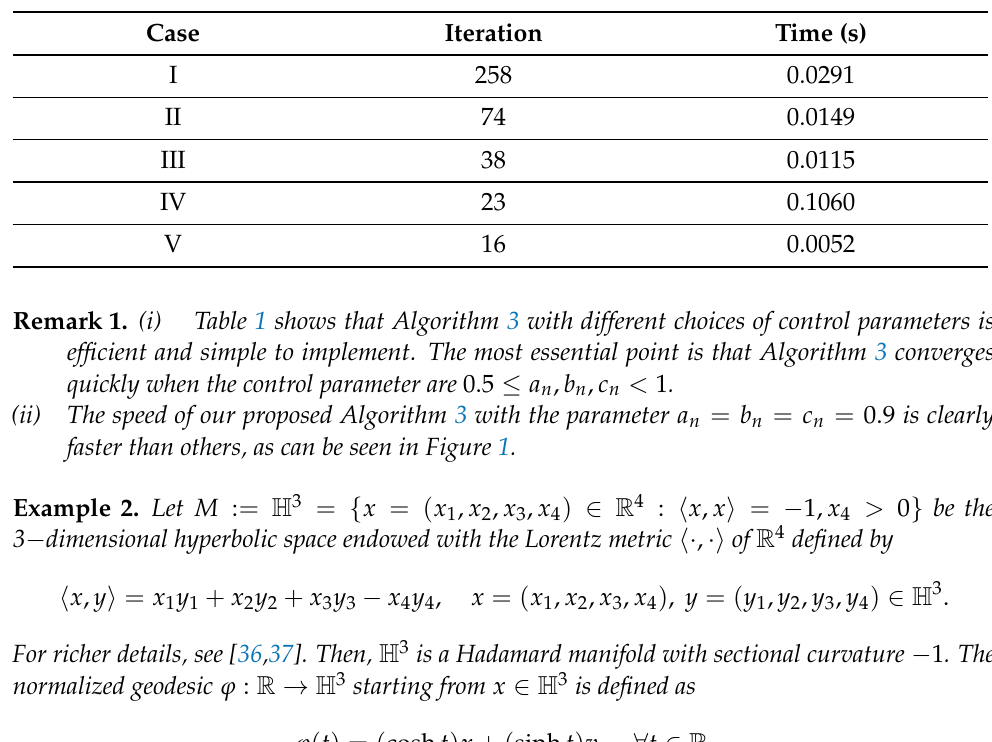
Table 1. Numerical experiments of Example